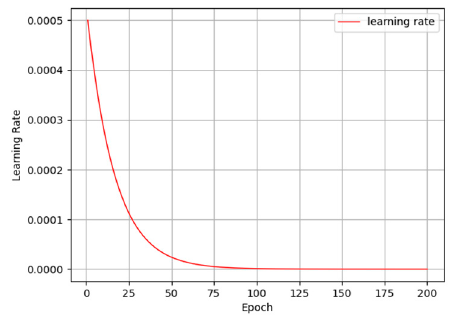
Figure 10. Learning rate decline curve.